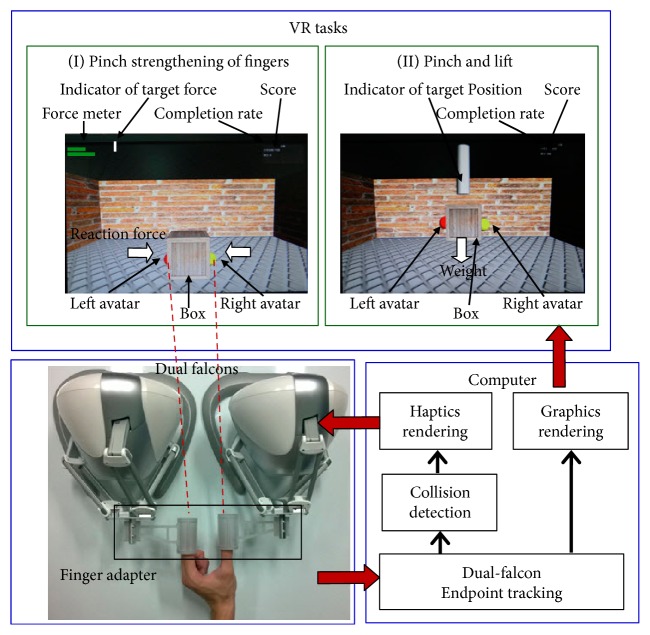
System architecture.